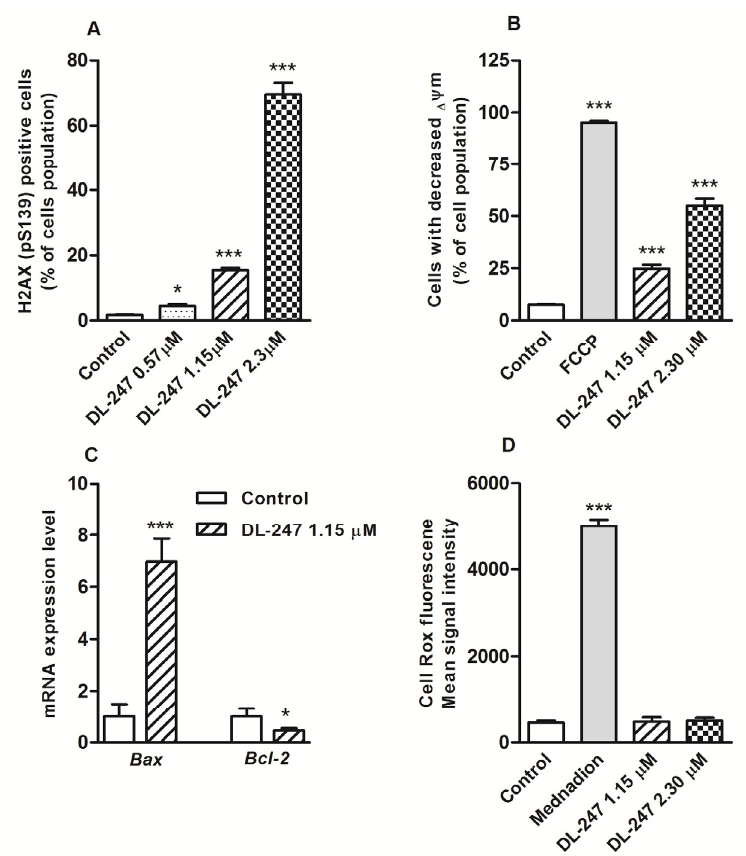
Figure 5. Analysis of typical features of intrinsic apoptosis pathway in HL-60 cells treated with DL-247 for 24 h. (A) Percentage of phosphorylated H2AX positive cells measured by flow cytometry (Alexa Fluor 647 Mouse Anti-H2AX (pS139) antibody staining). (B) Mitochondrial membrane potential ( ΔΨ m) changes measured by flow cytometry (JC-1 staining). FCCP (30 µM, 30 min incubation at 37 °C) was used as a positive control. (C) Bax and Bcl-2 gene expression changes analyzed by real-time PCR. (D) Intracellular ROS generation measured by flow cytometry (CellROX Green Reagent staining). Menadione (200 µM, 1 h incubation at 37 °C) was used as a positive